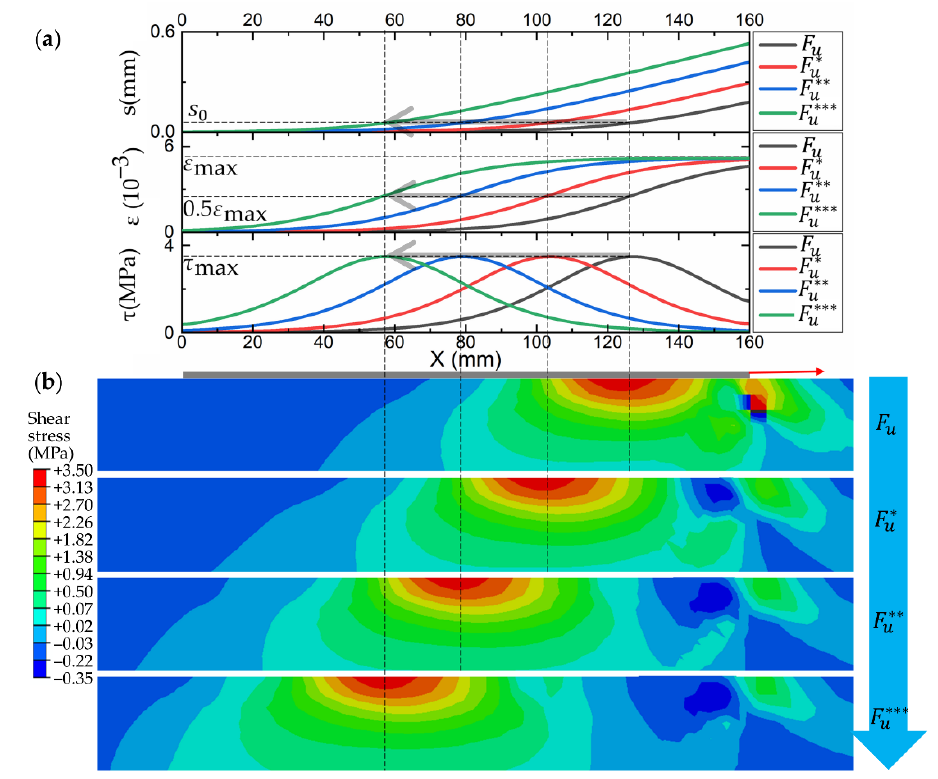
Figure 15. The development of interface debonding: ( a ) the slip distribution, strain distribution and shear bond stress distribution at different loading stages; ( b ) the shear bond stress contours at different loading stages.